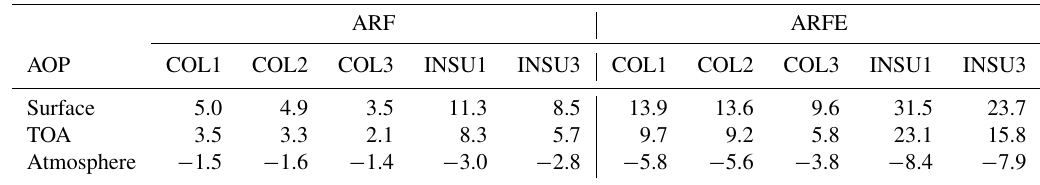
Table 8. LW ARF and ARFE at the surface, TOA, and in the atmosphere (in Wm − 2 ) on 22 June, calculated with the AOPs which produce the best agreement with respect to the irradiance profiles (COL1, COL2, COL3, and INSU3) and with INSU1 AOP in addition. ARF ARFE AOP COL1 COL2 COL3 INSU1 INSU3 COL1 COL2 COL3 INSU1 INSU3 Surface 5.0 4.9 TOA Atmosphere −